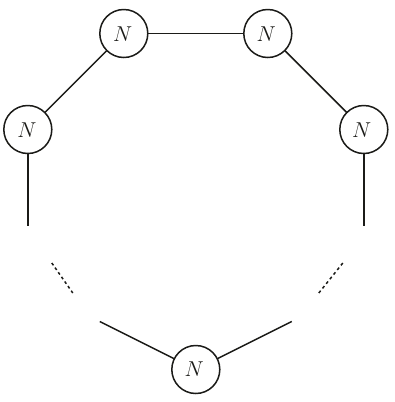
Figure 1 . The quiver diagram for the Z k orbifold theory. Each node stands for a vector multiplet with SU( N ) gauge group, each edge represents a bifundamental